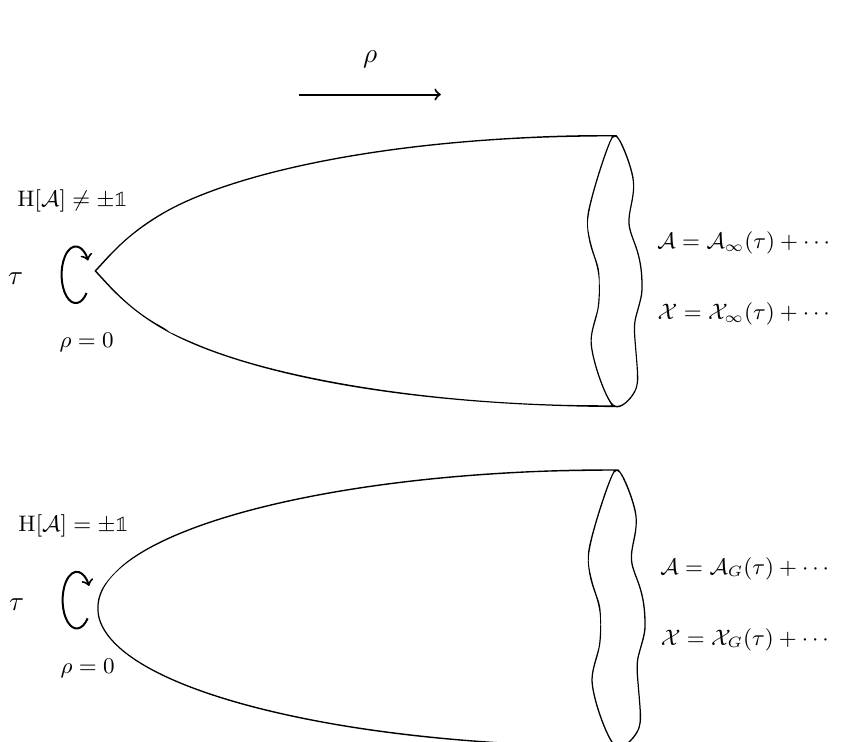
Figure 1 . Finite temperature and asymptotic symmetry in the gauge theory formulation. Eu- clidean black holes are represented by (cid:12)elds ( A ; X ) in a cigar-type geometry. The \Euclidean horizon" is located at (cid:26) = 0. Demanding the black hole to be at Hawking temperature (absence of holonomies, H[ A ] = (cid:6) 1 ) a(cid:11)ects the asymptotic symmetries. The asymptotic (cid:12)elds ( A 1 ( (cid:28) ) ; X 1 ( (cid:28) )) become ( A G ( (cid:28) ) ; X G ( (cid:28) )) consistently with smoothness of the